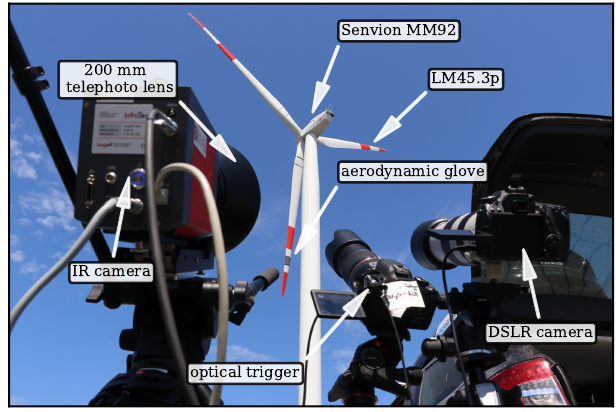
Figure 5. Experimental setup for thermographic flow visualization measurements. Foreground: thermographic camera with 200 mm telephoto lens, optical trigger, and DSLR camera for documentation